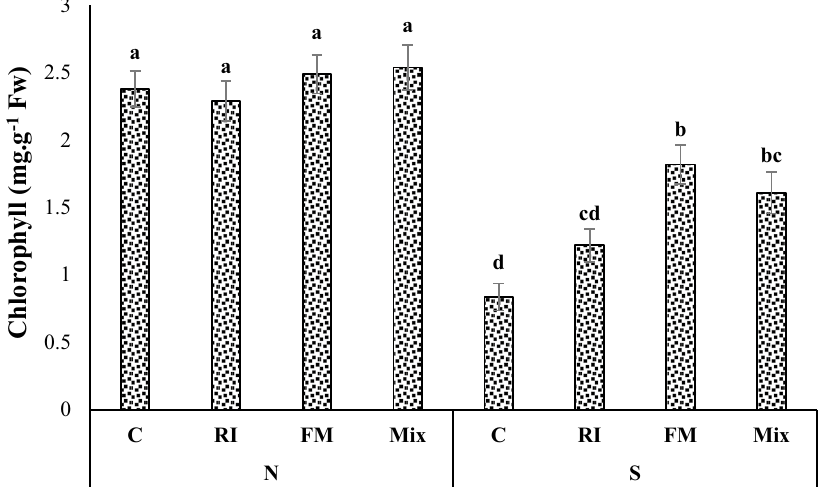
Figure 1. Interactions of irrigation regime × mycorrhizae on chlorophyll contents of Arizona cypress seedlings. N well watered (100% field capacity), S water stress (50% field capacity), RI Rhizophagus irregularis , FM Funneliformis mosseae ; Mix: R. irregularis – F. mosseae mixture; C: Non-inoculated plants.